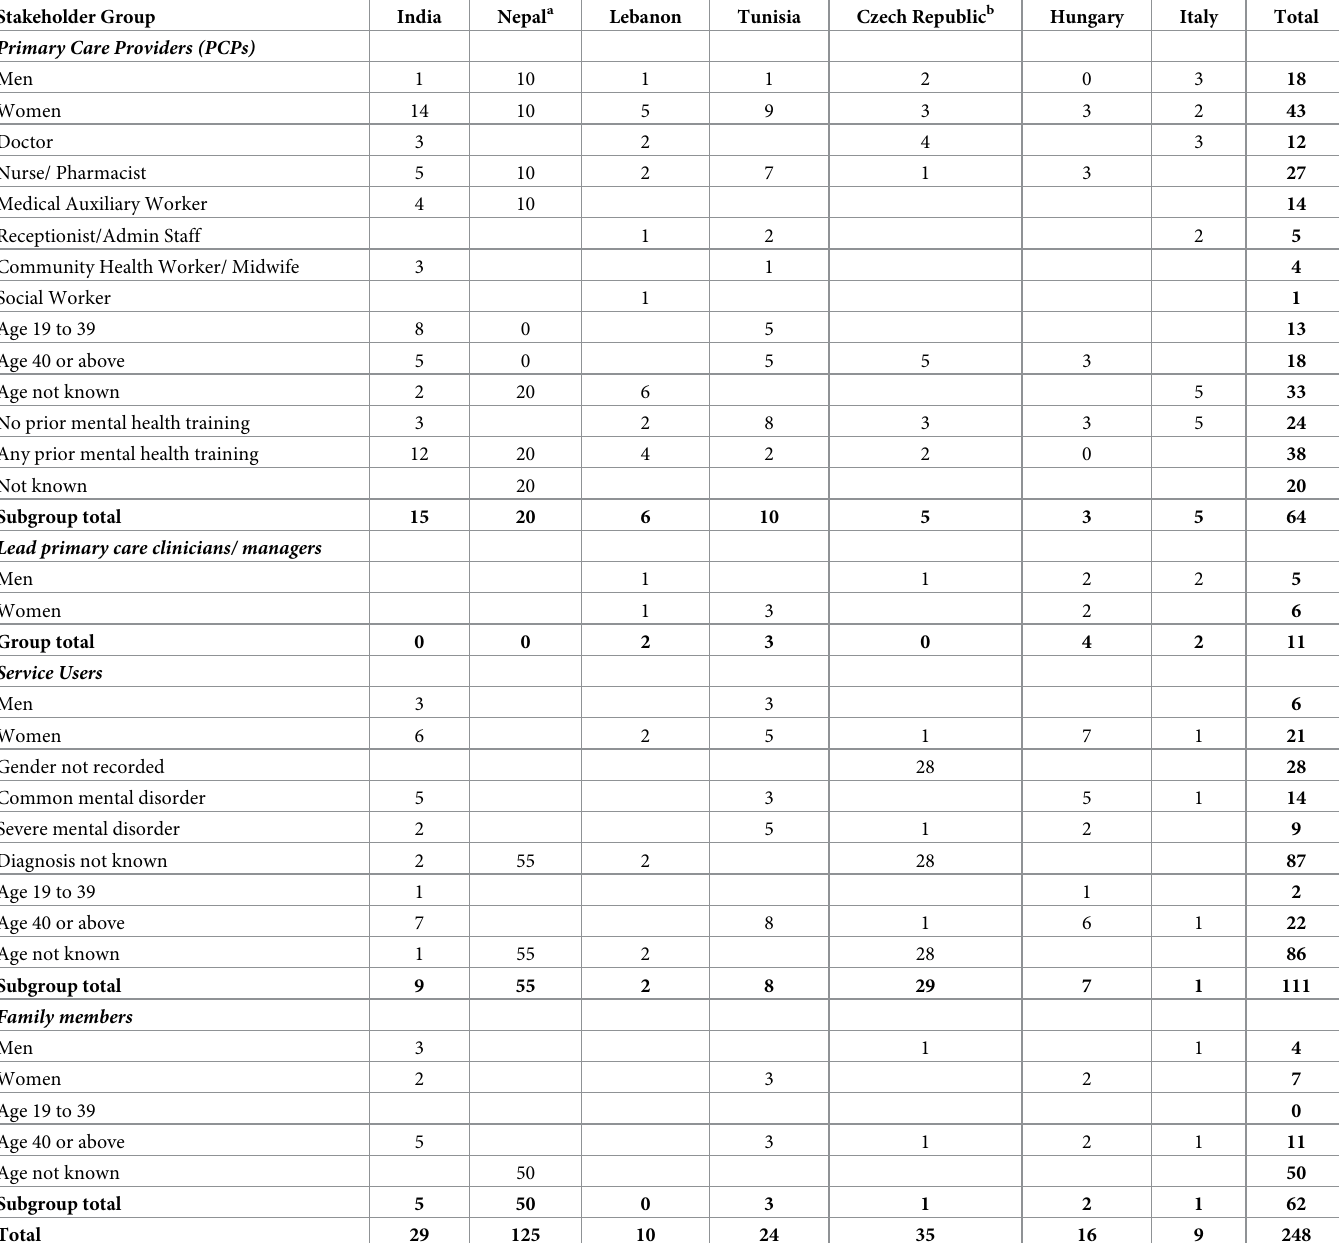
Table 3. Qualitative sample participant demographics. Stakeholder